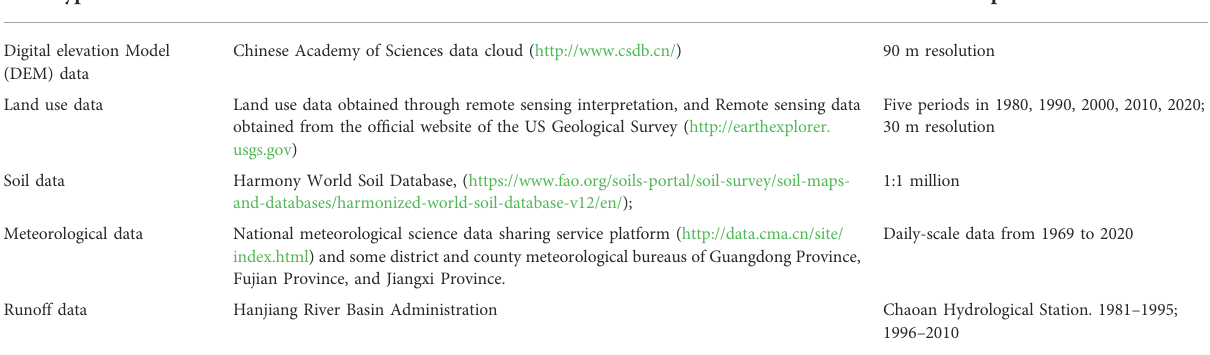
TABLE 1 Data used to construct the Soil and Water Assessment Tool for the Hanjiang River Basin,